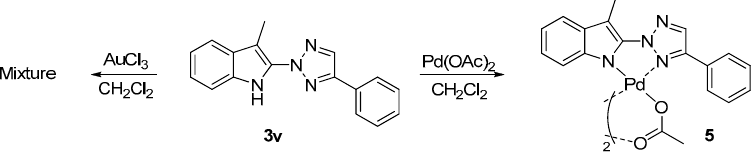
Scheme 3. The reaction of 3w with AuCl 3 and Pd(OAc) 2 .